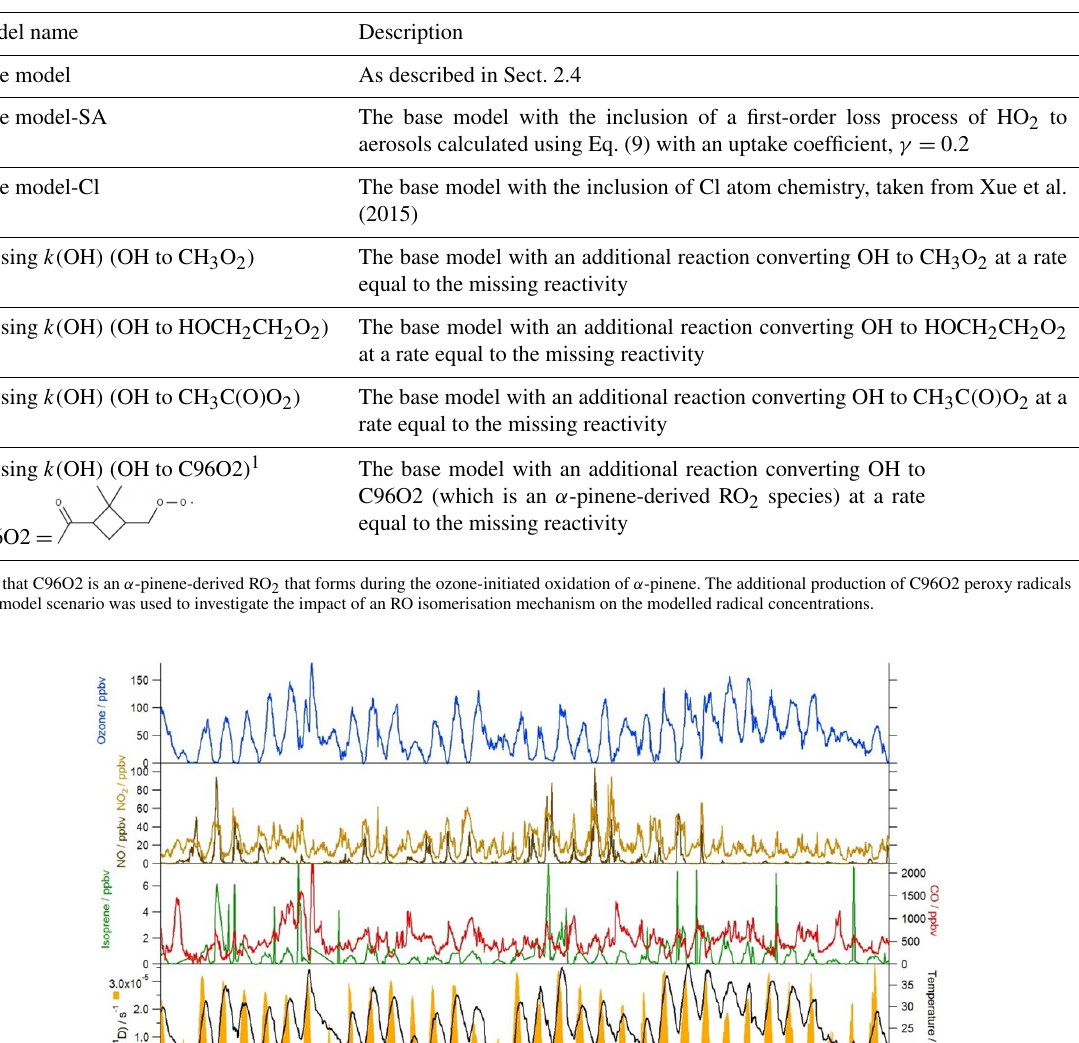
Table 3. Different model scenarios that are discussed in Sect. 3.